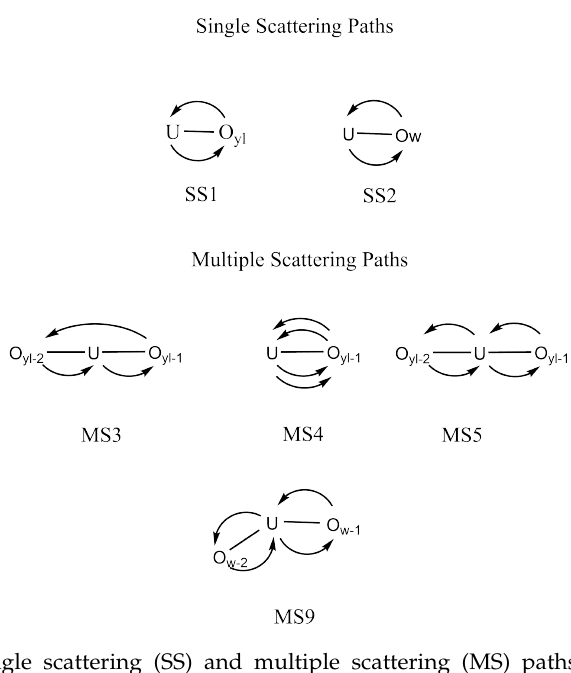
Figure 4. Main single scattering (SS) and multiple scattering (MS) paths contributing to the EXAFS signal.